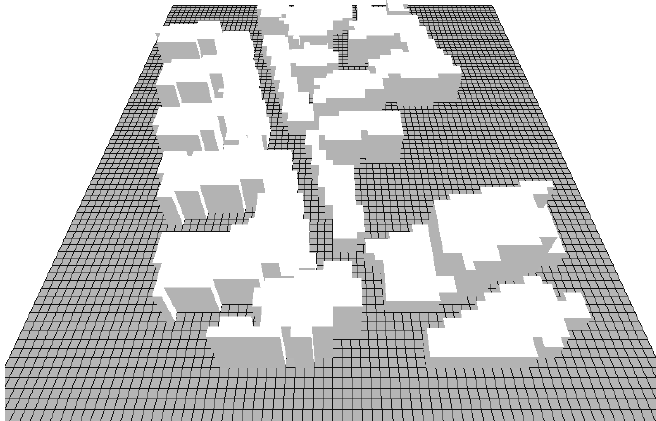
Figure 1. Envi-met model of Yuhou Street.